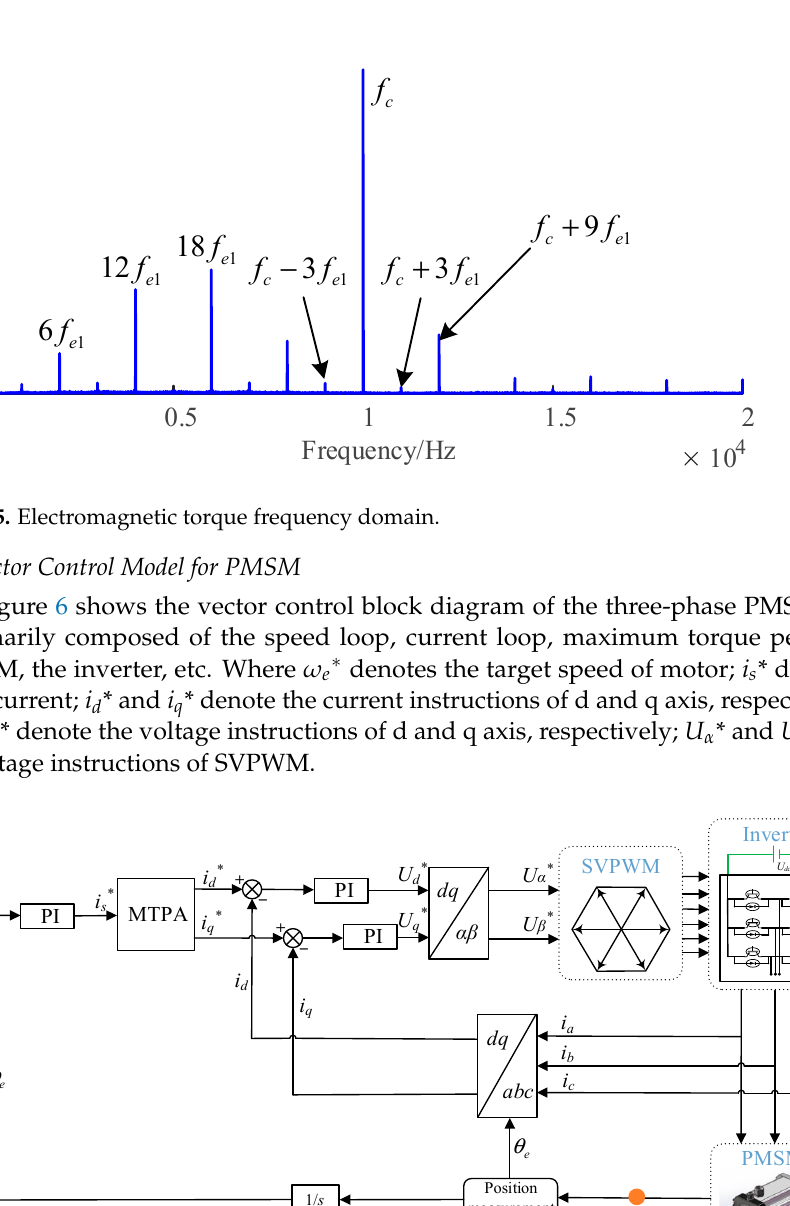
has a current frequency. The format is presented as | a f e1 ± f c | ( a = 1, 2, . . . ).